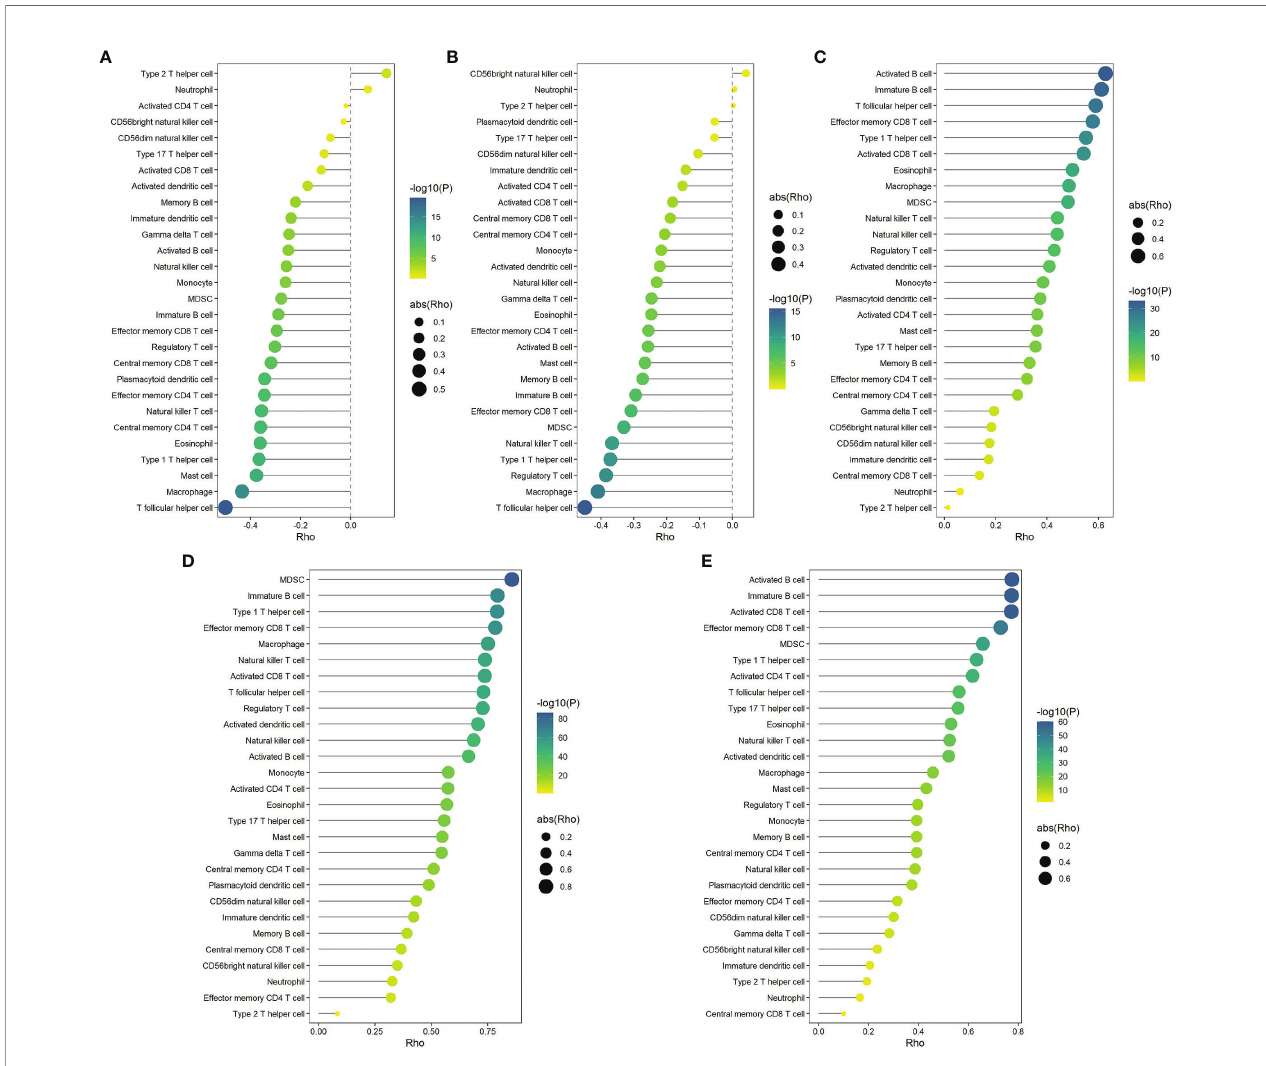
FIGURE 13 | Correlations of the expression of DYNC2I2 (A) , MARVELD2 (B) , RASSF2 (C) , FERMT3 (D) and RASSF5 (E) with 28 microenvironment cells (based on the METABRIC cohort). Correlation coef fi cients were calculated by Spearman analysis. The color represents P values, and the size of the circles represents the absolute value of correlation coef fi cients. Larger circles represent bigger